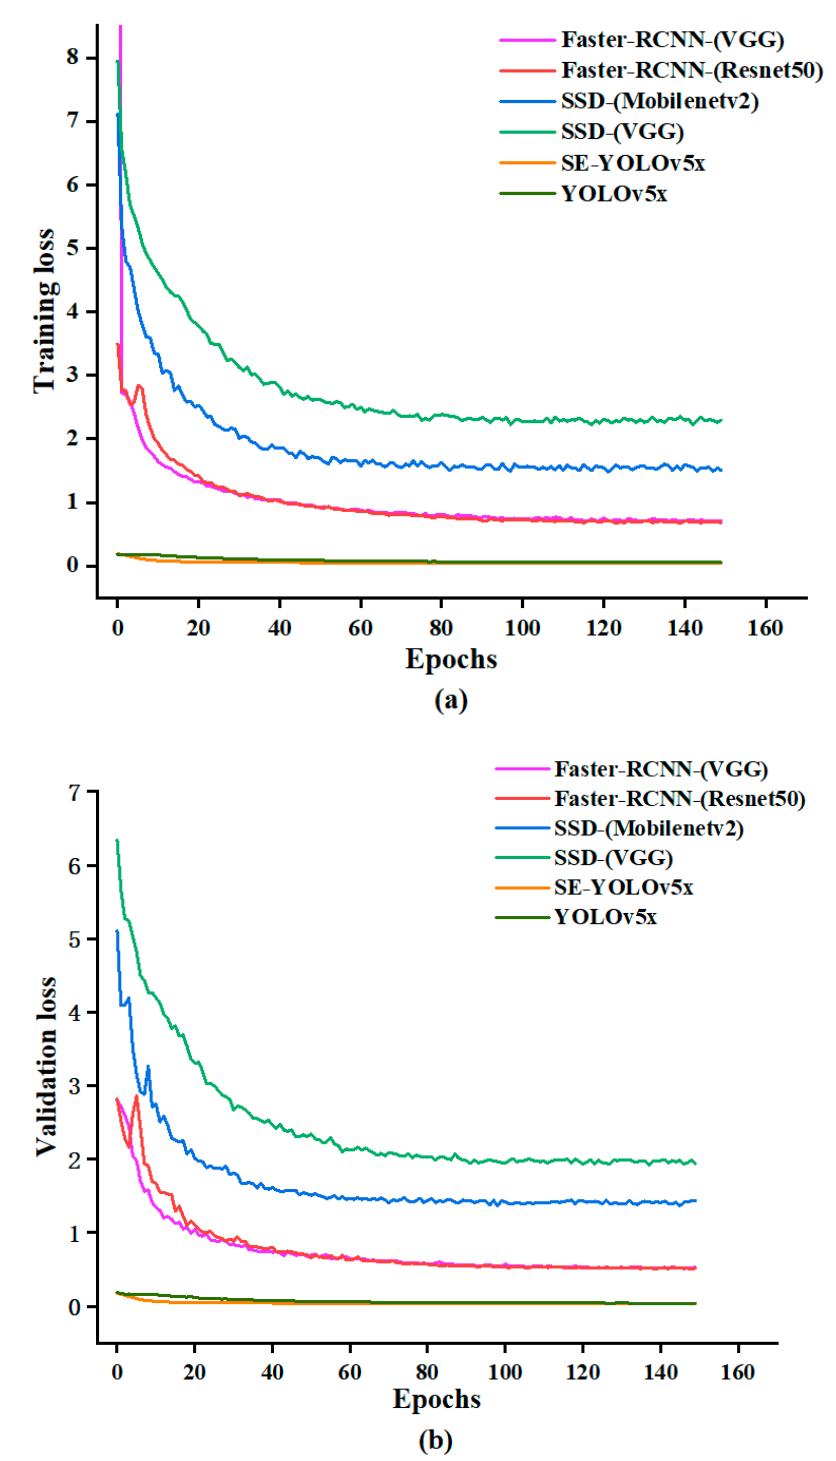
Figure 10. ( a ) Training loss curves and ( b ) validation loss curves against the number of epochs in weed–lettuce classification.